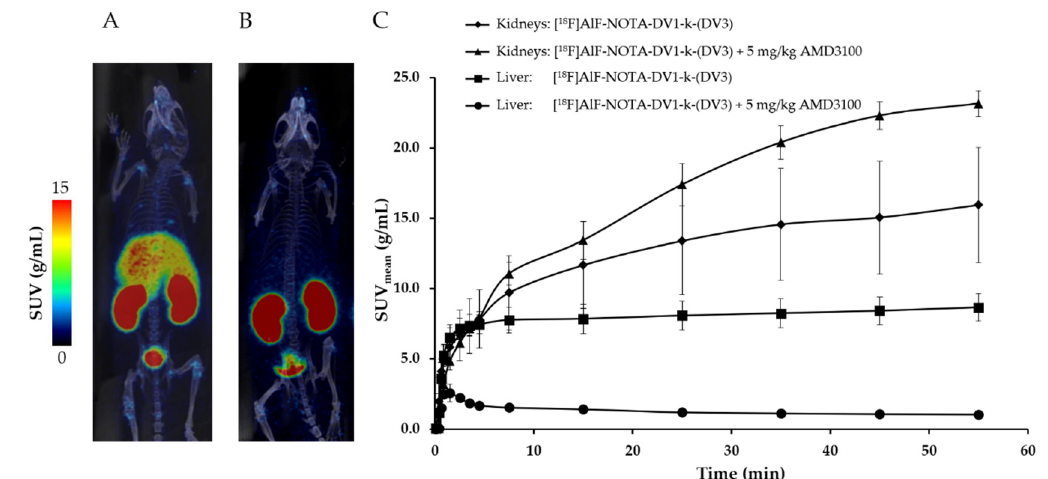
Figure 2. ( A,B ) Positron emission tomography (PET)/computed tomography (CT) imaging in wild-type mice. Averaged maximum intensity projection (MIP) image (50–60 min post-injection (p.i.)): ( A ) [ 18 F]AlF-NOTA-DV1-k-(DV3) ( n = 5), ( B ) [ 18 F]AlF-NOTA-DV1-k-(DV3) + 5 mg/kg AMD3100 ( n = 2). ( C ) Time-activity curves (TACs) expressed in mean standard- ized uptake value (SUV mean ) (SUV averaged over organ volume) for kidneys and liver. All data are expressed as mean ± SD.